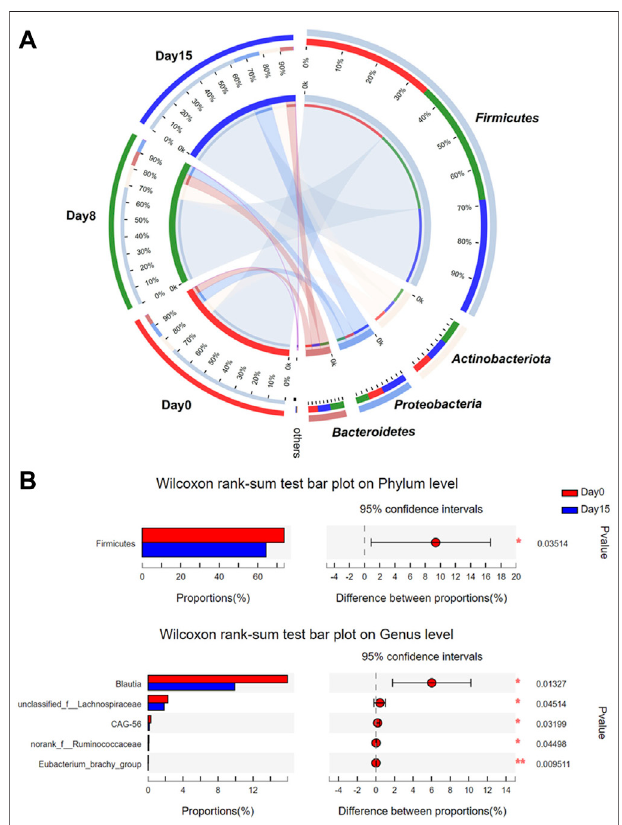
FIGURE 2 | Component comparison analyses of bacterial community structure after HXZQ administration on donors with healthy state of gut microbiome ( n = 30). (A) Circos analysis was used to visualize bacterial community structure at each time point. (B) Visual representation of p -values obtained from comparison of an individual in group days 0 and 15. Wilcoxon rank-sum test was applied. * p -value < 0.05; ** p <